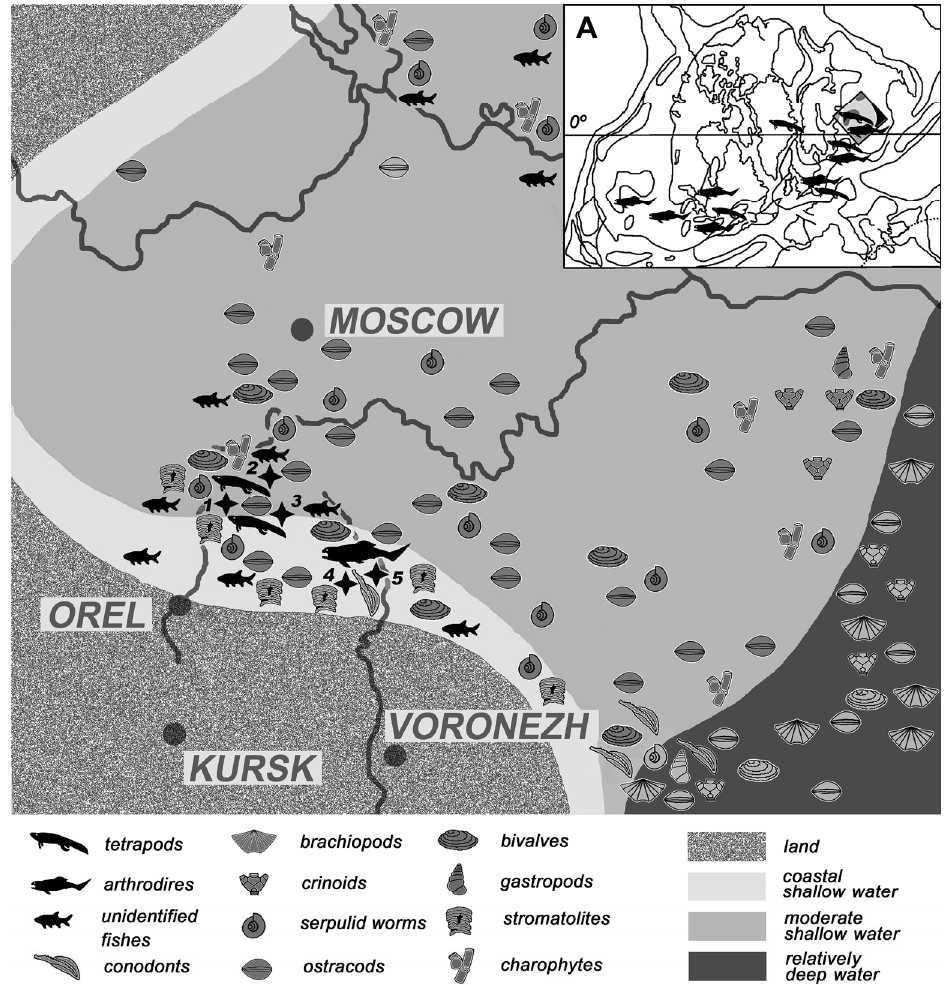
Fig. 2. Palaeobiogeographic scheme of the Khovanshchinian basin in the central part of the East European Platform. A , arthrodires and palaeotetrapod communities in Laurentia and Baltica palaeozoogeographic provinces. Localities: 1 , Gorbachevo quarry; 2 , Andreyevka-2; 3 , Draguny; 4 , Voskresenskoye quarry; 5 , Kolesovo quarry. Conodont data after Aristov (1988), palaeogeographic setting and data on other invertebrate groups after Makhlaev (1964). Data on the areas inhabited by tetrapods and arthrodires by the